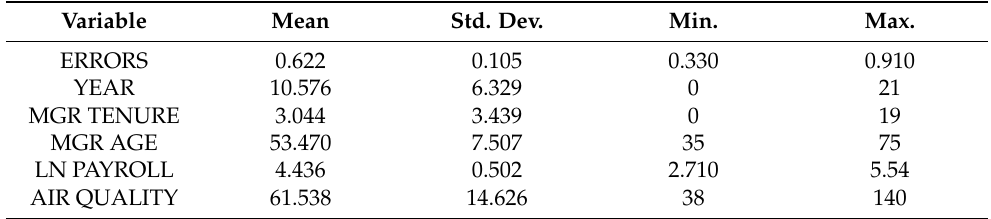
Table 1. Descriptive statistics for MLB